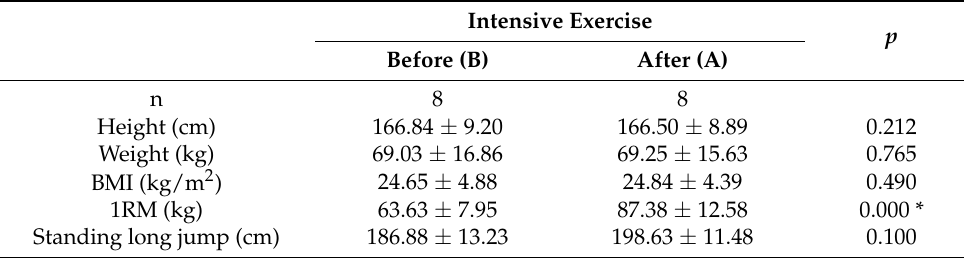
Table 1. Basic mean information of bottom groups.